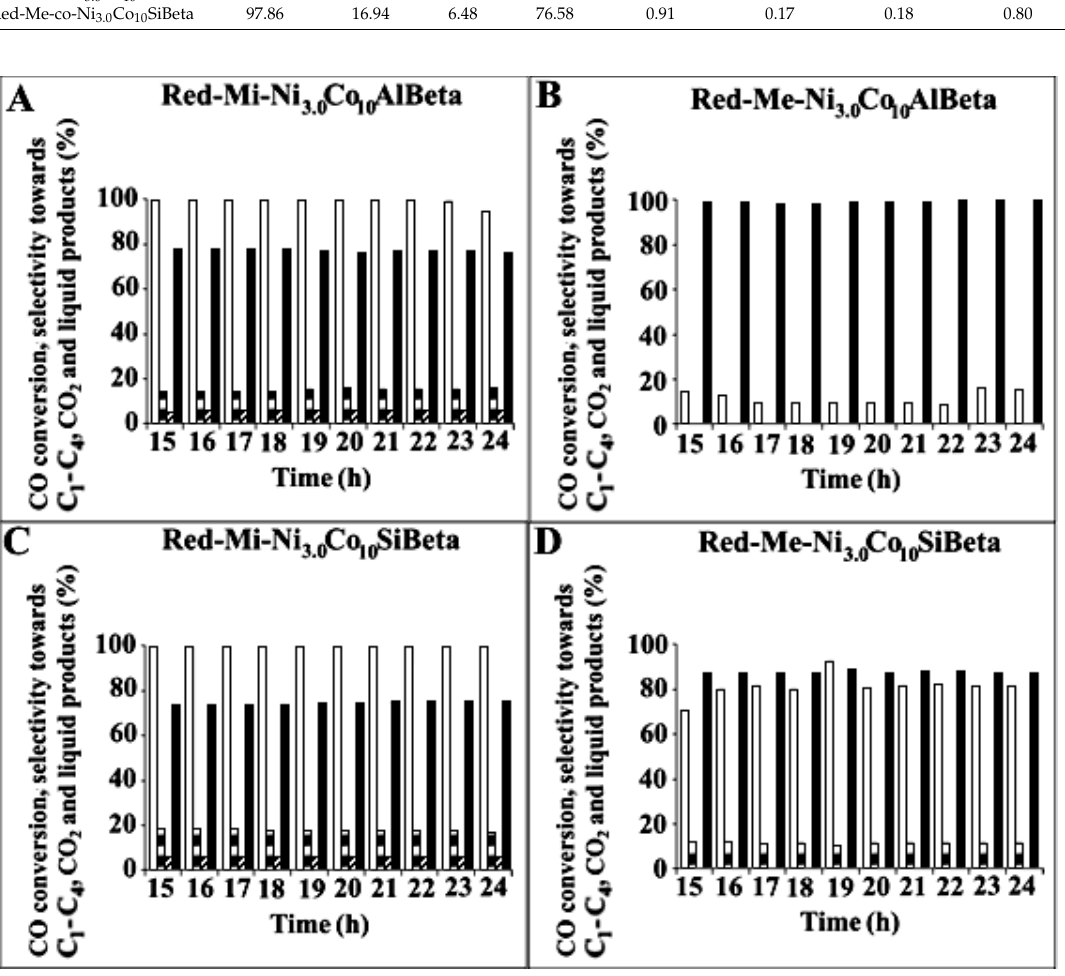
Figure 9. Conversion of CO ( ) and selectivity to C 1 -C 4 ( ), CO 2 ( ) and liquid products ( ) after Fischer-Tropsch synthesis (T = 260 °C, p = 30 atm, t = 24 h) over ( A ) Red-Mi-co-Ni 3.0 Co 10 AlBeta, ( B ) Red-Me-co-Ni 3.0 Co 10 AlBeta, ( C ) Red-Mi-co-Ni 3.0 Co 10 SiBeta, ( D ) Red-Me-co-Ni 3.0 Co 10 SiBeta.